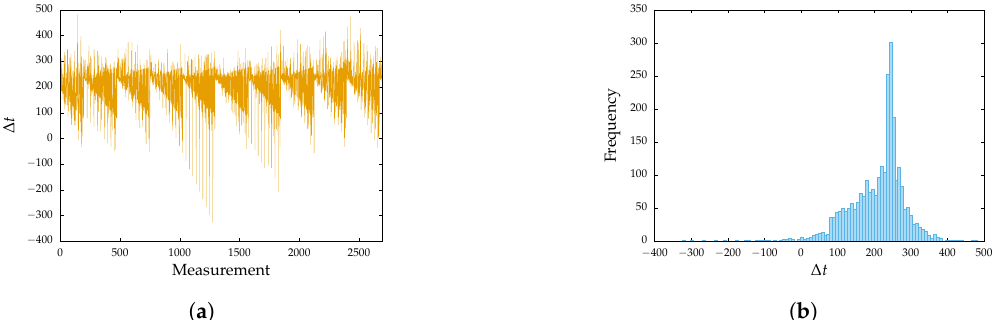
Figure 5. Results related to synchronization: ( a ) time difference ∆ t between Coordinator and Router clocks; and ( b ) histogram of ∆ t